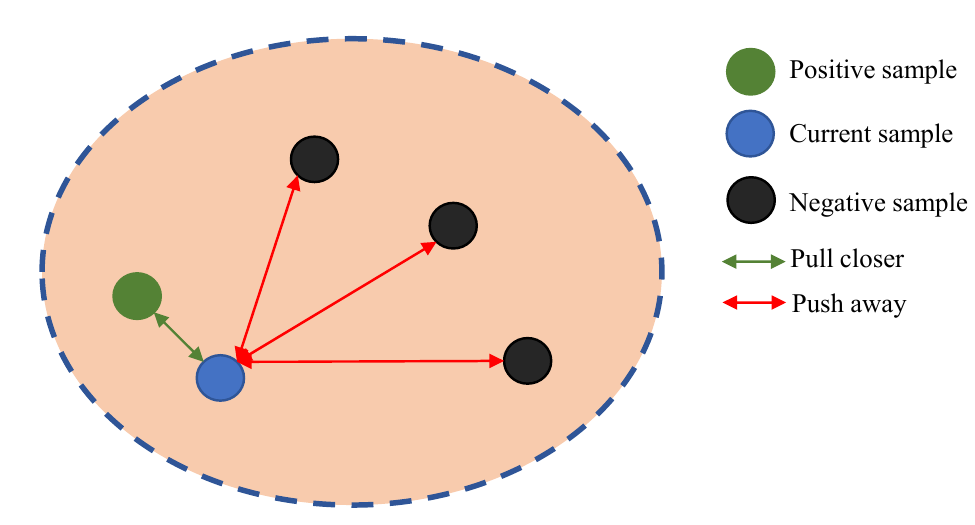
Figure 7. The goals of contrastive